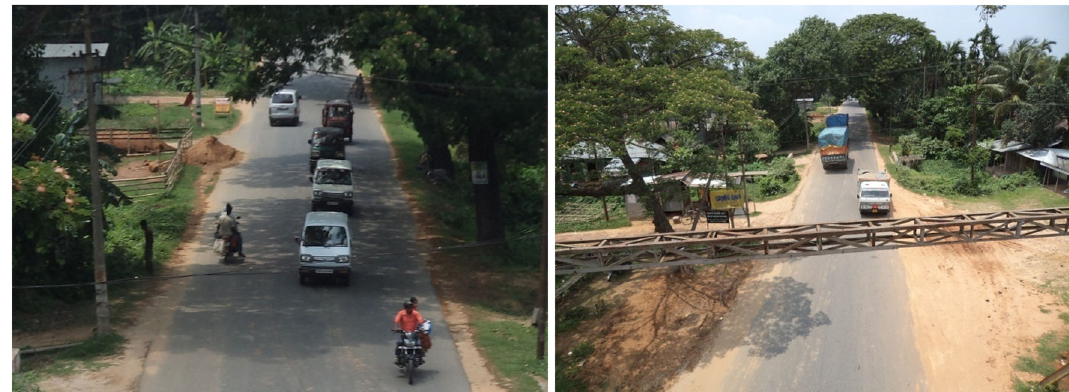
Fig. 1 Camera view at study section (image by author)